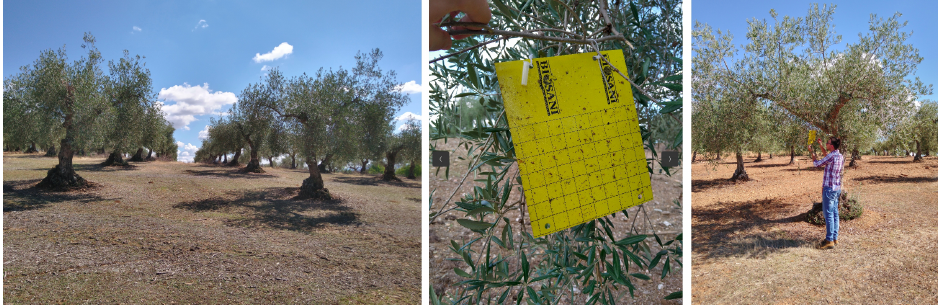
Figure 1. Arrangement of olive groves in the cultivation zone ( left ), yellow chromotropic trap ( centre ), and positioning of the trap carried out by the operator on the ground ( right